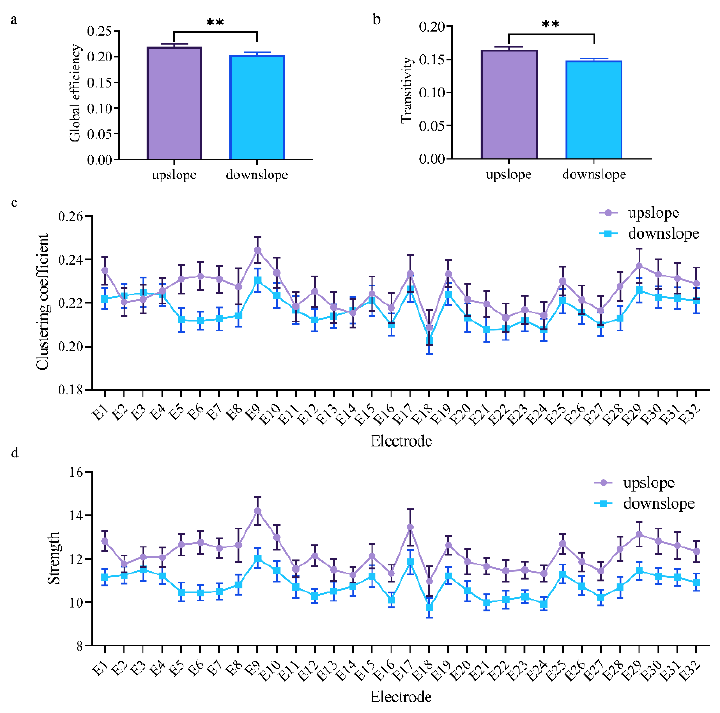
Figure 8. Indexes of the brain network for the two locomotion states in the low gamma band (30– 50 Hz). ( a , b ) Global indexes of the brain network, including global efficiency and transitivity. ( c , d ) Local indexes of the brain network, including clustering coefficient and strength. All error bars indicate the 95% confidence interval of the mean. ** p ≤ 0.01.